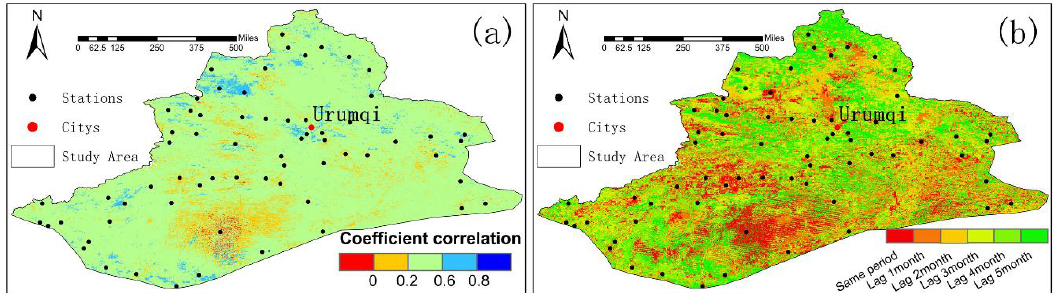
Figure 7. Spatial distribution of maximum cross-correlation ( a ) between NDVI and humidity index and time-lag response ( b ) in the Xinjiang region.